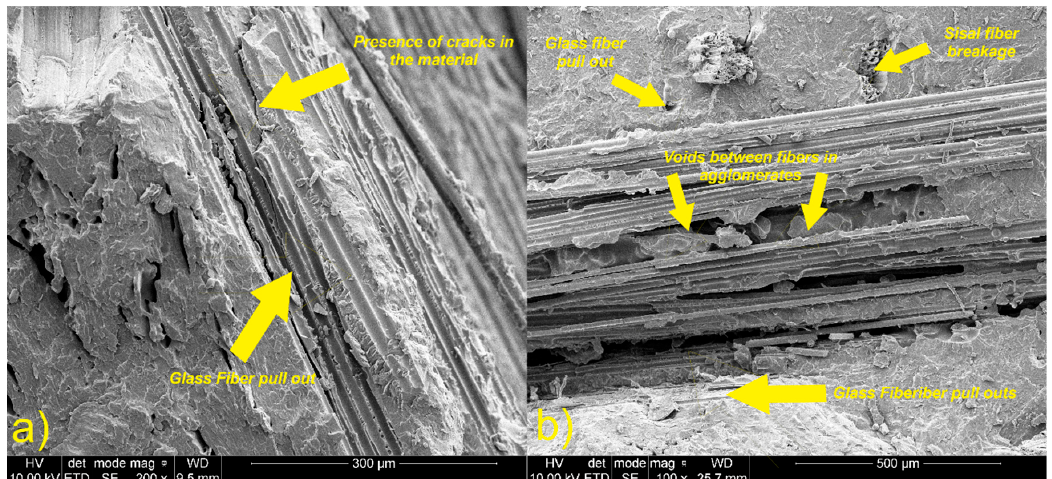
Figure 17. SEM images of glass fiber in composite, ( a ) group of defects in material; ( b ) agglomerate of glass fibers.